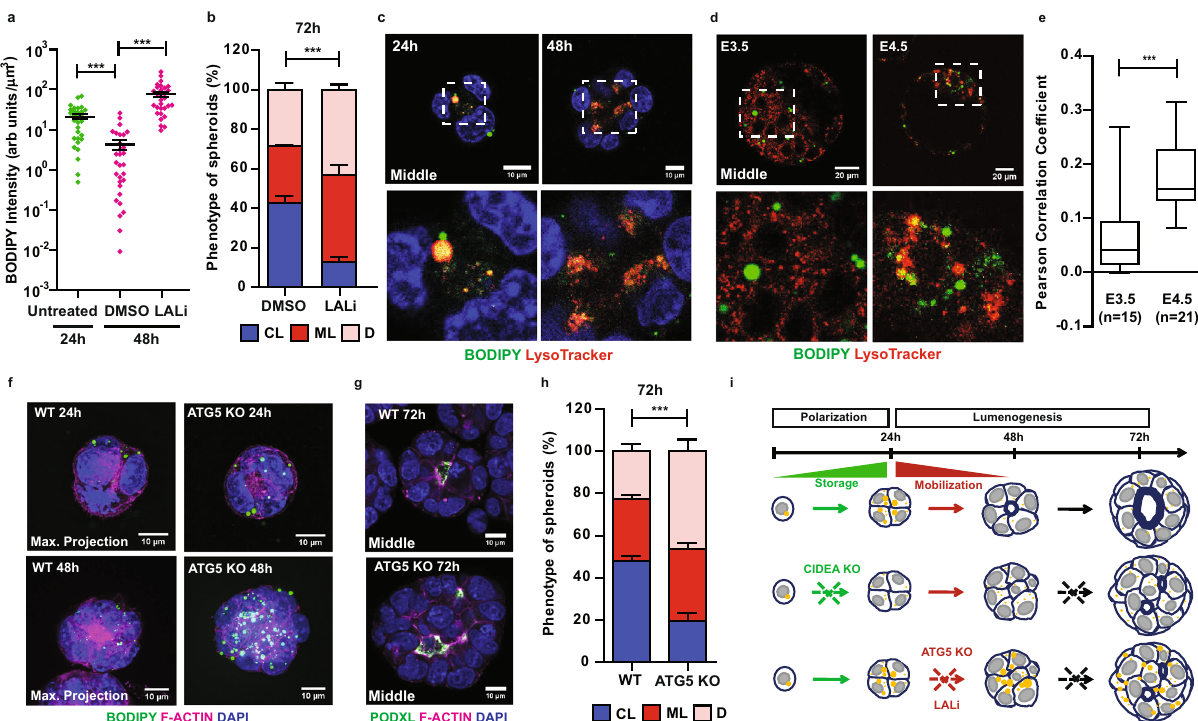
Fig. 5 Lipophagy-dependent mobilization of lipid storage is required for polarity-driven lumenogenesis. a Quanti fi cation of neutral lipid content using BODIPY 493/503 staining (BODIPY fl uorescence intensity normalised to spheroid volume) in WT spheroids before (24 h; green) and after (48 h; magenta) culturing with DMSO or LAListatII (LALi) (see also Supplementary Fig. 7a, b). n = 30 spheroids per condition and time-point. Error bars, means ± s.e.m. ( n = 3); two-sided Mann – Whitney U test; *** p < 0.001; exact p-values: untreated 24 h vs DMSO 48 h, p = 2.4 × 10 − 6 ; DMSO 48 h vs LALi 48 h, p = 0.00012. b Quanti fi cation of the phenotype of WT spheroids (72 h) after culturing with DMSO or LALi for 48 h (see also Supplementary Fig. 7c, d). n (cid:1) 185 spheroids; error bars, means± s.e.m. ( n = 3); two-sided Chi-square (Fisher exact) test; *** p < 0.001 ( p = 5.6 × 10 − 14 ). CL, central-lumened; ML, multi-lumened; D, disorganised. c Representative live-cell imaging of LysoTracker-labelled lysosomes, BODIPY-labelled LDs, and Hoechst 33342-labelled nuclei in WT ESC-induced spheroids. Squares indicate magni fi ed regions. The analysis was performed on at least two independent experiments ( n (cid:1) 2). d Representative images of lysosomes and LDs in E3.5 (~98 h post-hCG injection) and E4.5 (~122h post-hCG injection) blastocysts stained as in ( c ). e Co- localisation analysis of fl uorescence signals from ( d ). Pearson Correlation Coef fi cient ( + 1, correlation to − 1, anti-correlation); two-sided Mann – Whitney U test; *** p < 0.001 ( p = 2.6 × 10 − 13 ); n = 15 – 21 blastocysts. Box limits = 25th − 75th percentiles; centre lines = medians; whiskers end = min. and max. values. f Images of BODIPY-stained LDs in spheroids formed by WT and ATG5 KO ESCs at indicated time-points ( n = 3). g Representative images of spheroids formed by WT and ATG5 KO ESCs at 72 h post- induction of differentiation. Foci of lumen formation are marked by PODXL and F-ACTIN. h Quanti fi cation of the phenotype of WT and ATG5 KO spheroids from ( g ) (see also Supplementary Fig. 8g, h). n (cid:1) 167 spheroids; error bars, means ± s.e.m. ( n = 3); two-sided Chi-square (Fisher exact) test; *** p < 0.001 ( p = 1 × 10 − 8 ). CL, central-lumened; ML, multi-lumened; D, disorganised. i Scheme model summarising the fi ndings of this study. Source data are provided as a Source data fi